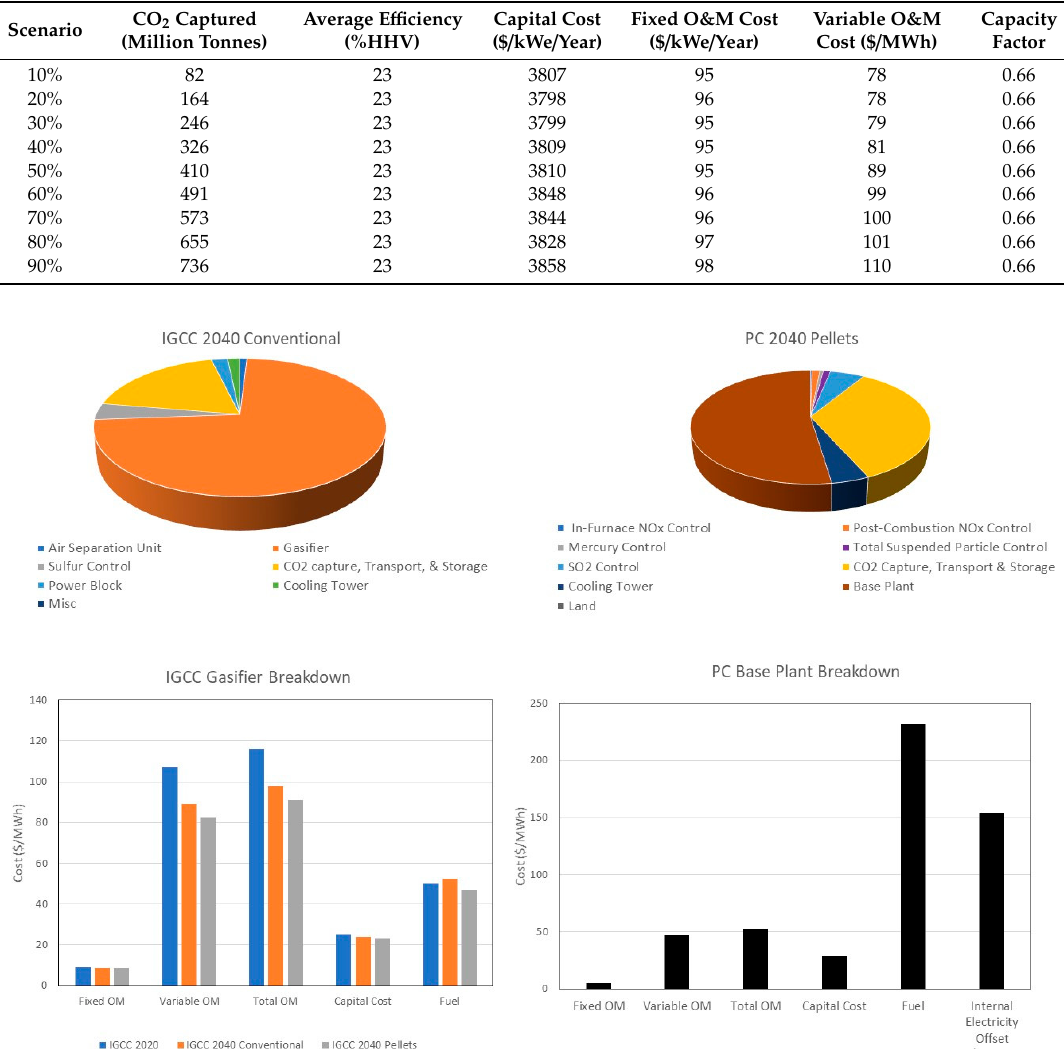
Table 7. Average e ffi ciency (%HHV), capital cost ($ / kWe), fixed O&M cost ($ / kWe / year), variable O&M cost ($ / MWh), and capacity factor for the pulverized combustion 2040 advanced (pelletized) logistics scenario.